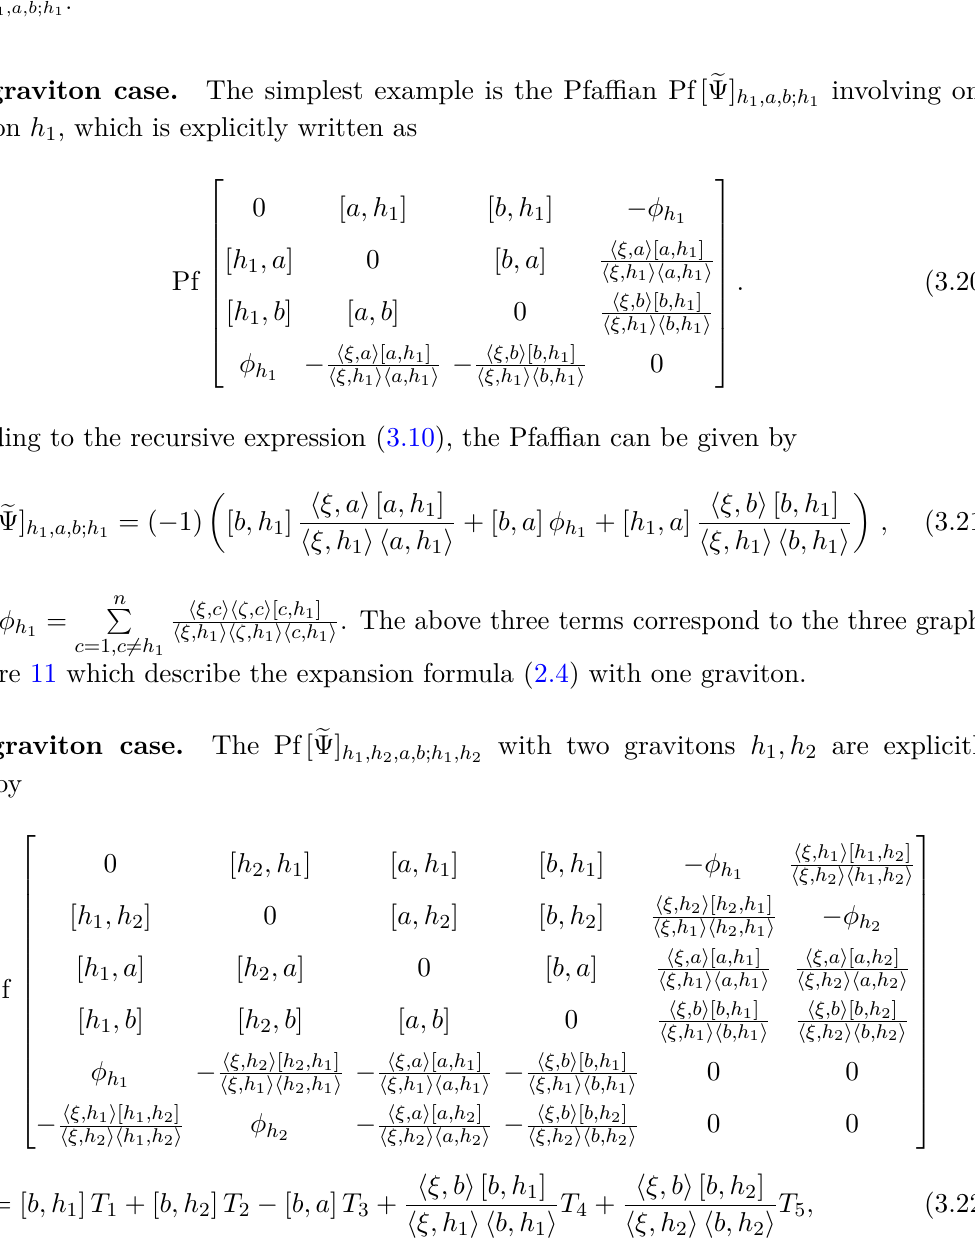
Figure 11 . Three graphs corresponding to the three terms of the expansion of one-graviton Pfaffian Pf [ e Ψ] h 1 ,a,b ; h 1